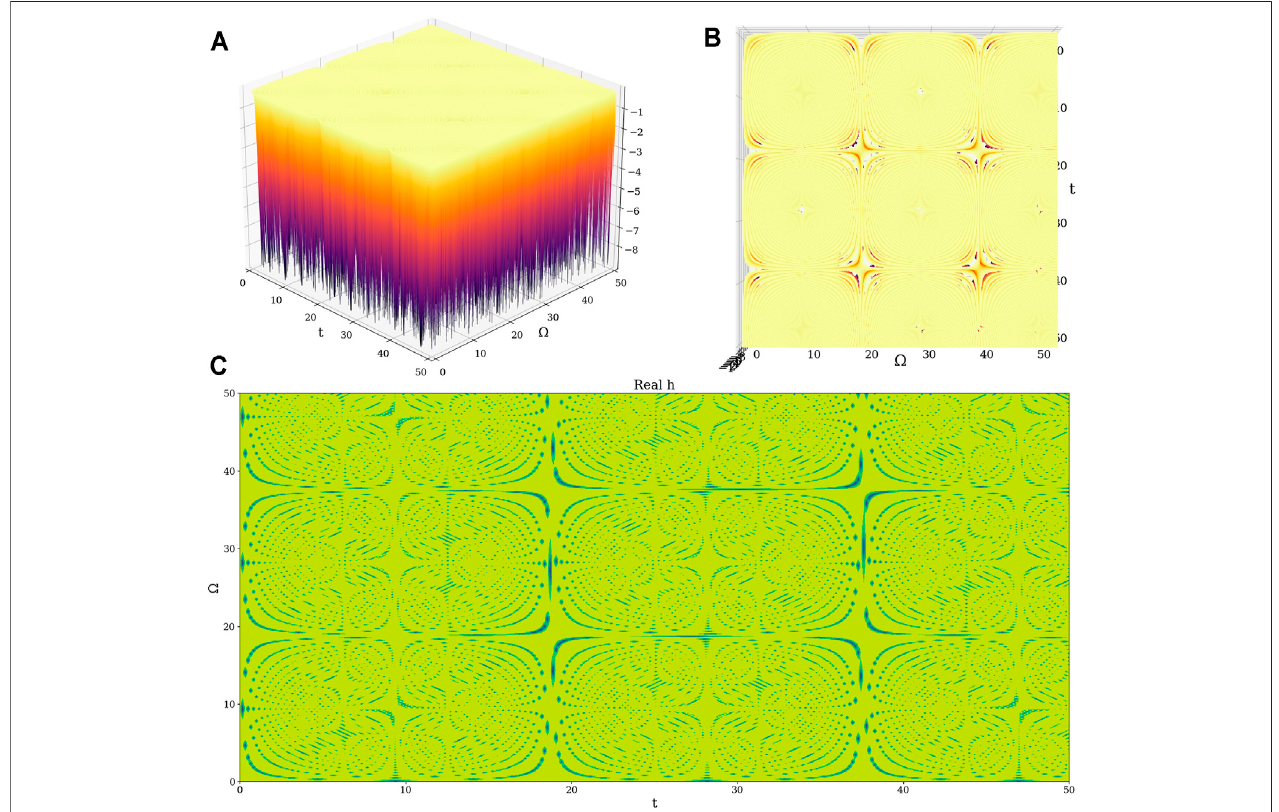
FIGURE 2 | Example 3D plot of Re [ h ( Ω , t )] ; (A) Φ (cid:2) 2 . 35, (B) (top, i.e., positive values); Φ (cid:2) 2 . 35 and (C) example 2D plot of Re [ h ( Ω , t )] ; Φ (cid:2) 2 . 35.